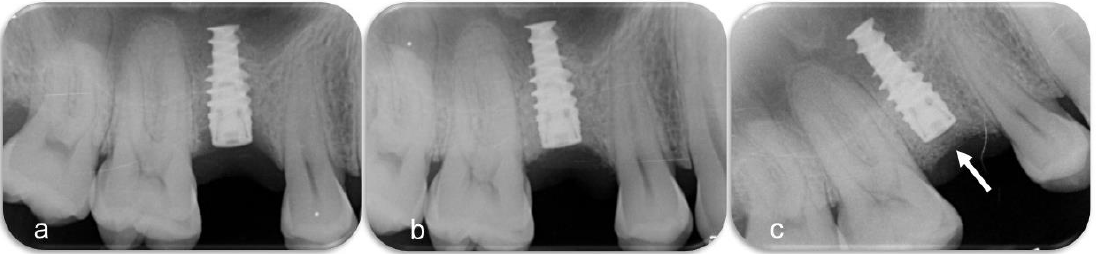
Figure 8. a. The defect at baseline looks much less severe than in clinical reality. b. Augmented defect. 255